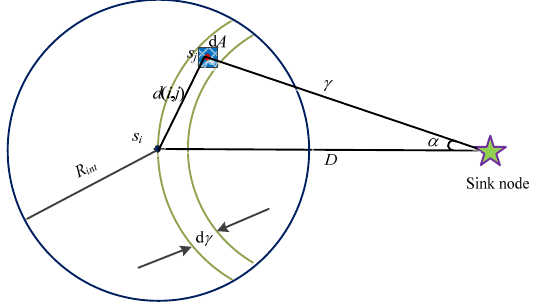
Figure 2. Sensing network model with multi-hop nodes.